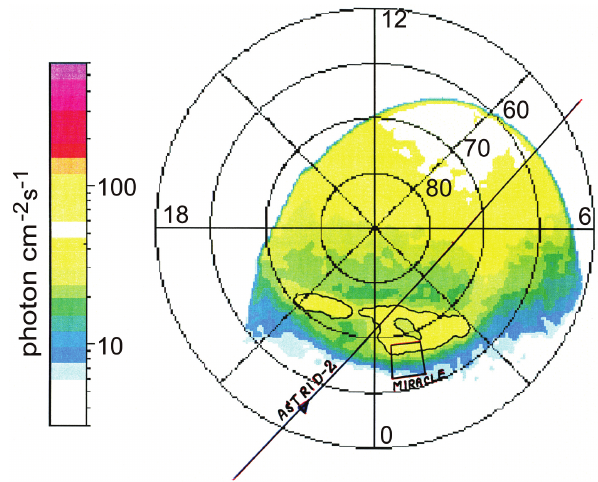
Fig. 1. Polar UV image of a nightside auroral bulge observed on 7 May 1999 at 22:22 UT. Superposed on the image are the footpoint of the Astrid-2 orbit (2033) and the field-of-view of the MIRACLE ground-based network in northern